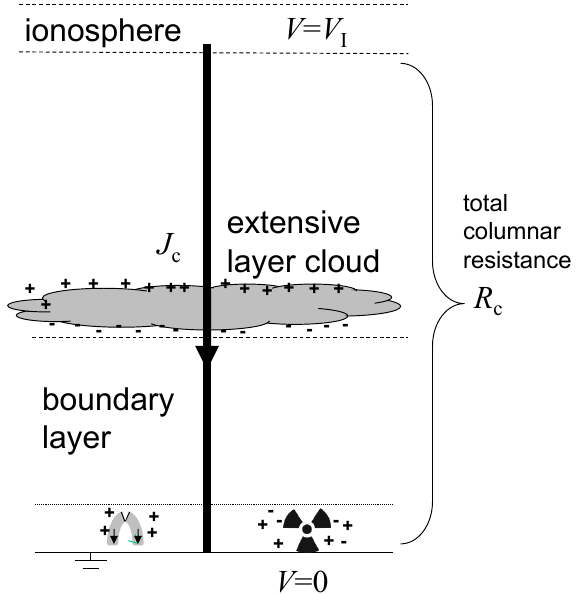
Fig. 1. Coupling of surface ionisation changes to layer clouds through the global circuit. The conduction current flowing (density J c ) is related to the vertical columnar resistance R c and the glob- ally established ionospheric potential V I . The boundary layer in the base of the lower atmosphere contributes the majority of the colum- nar resistance. Hence, ionisation released into this region by rock fracturing (shown on the left) or radioactivity (shown on the right) will reduce R c and increase J c for fixed V I , from Ohm’s Law. The charge accumulating on cloud droplets at the upper and lower cloud boundary is proportional to J c and, therefore, in turn, to the sur- face ionisation. This charge may influence the cloud microphysical processes, e.g. via droplet